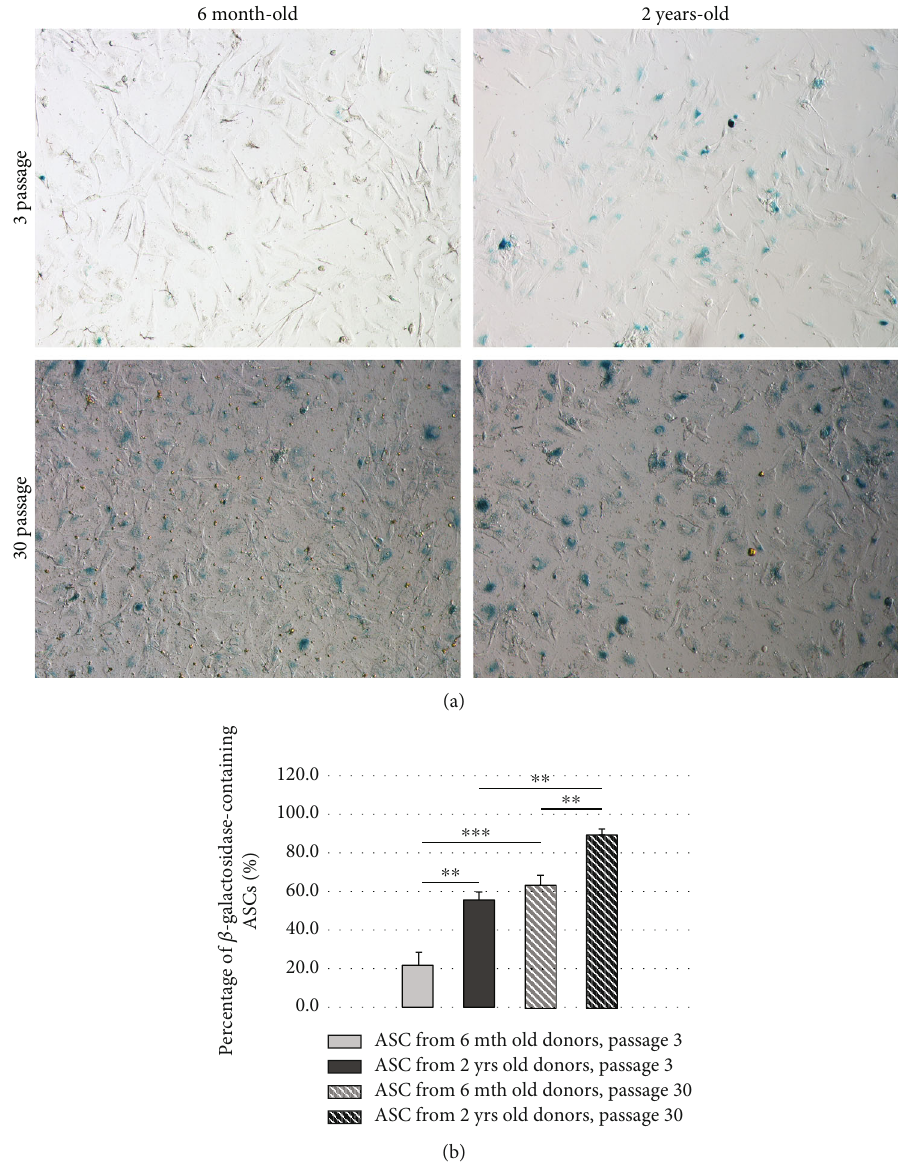
Figure 5: (a) Endogenous – β -galactosidase (blue) in ASC cultures from 6mth donors, p. 3; 2 yrs. donors, p. 3; 6mth donors, p. 30; 2yrs. donors, p. 30. Light microscope, mag. 10x; (b) comparison of β -galactosidase-containing ASCs from 6 mth donors, p. 3; 2yrs. donors, p.